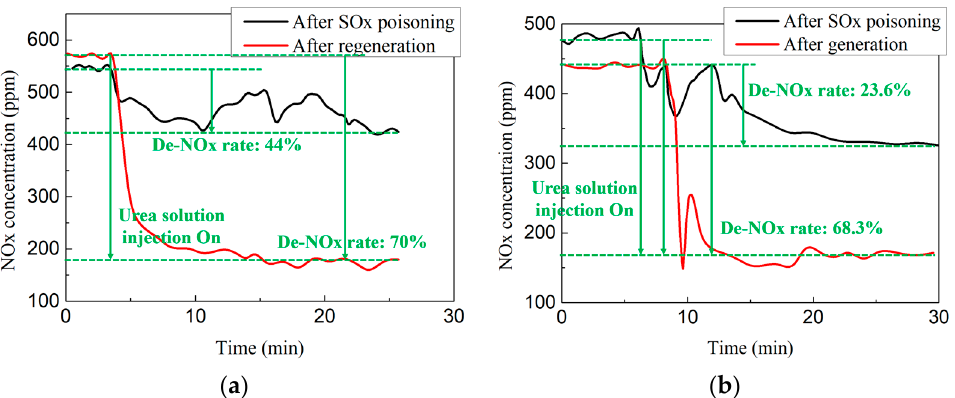
Figure 18. De-NOx performance with burner operation after SOx poisoning and after regeneration under different temperature conditions; ( a ) Case 1, ( b ) Case 2.